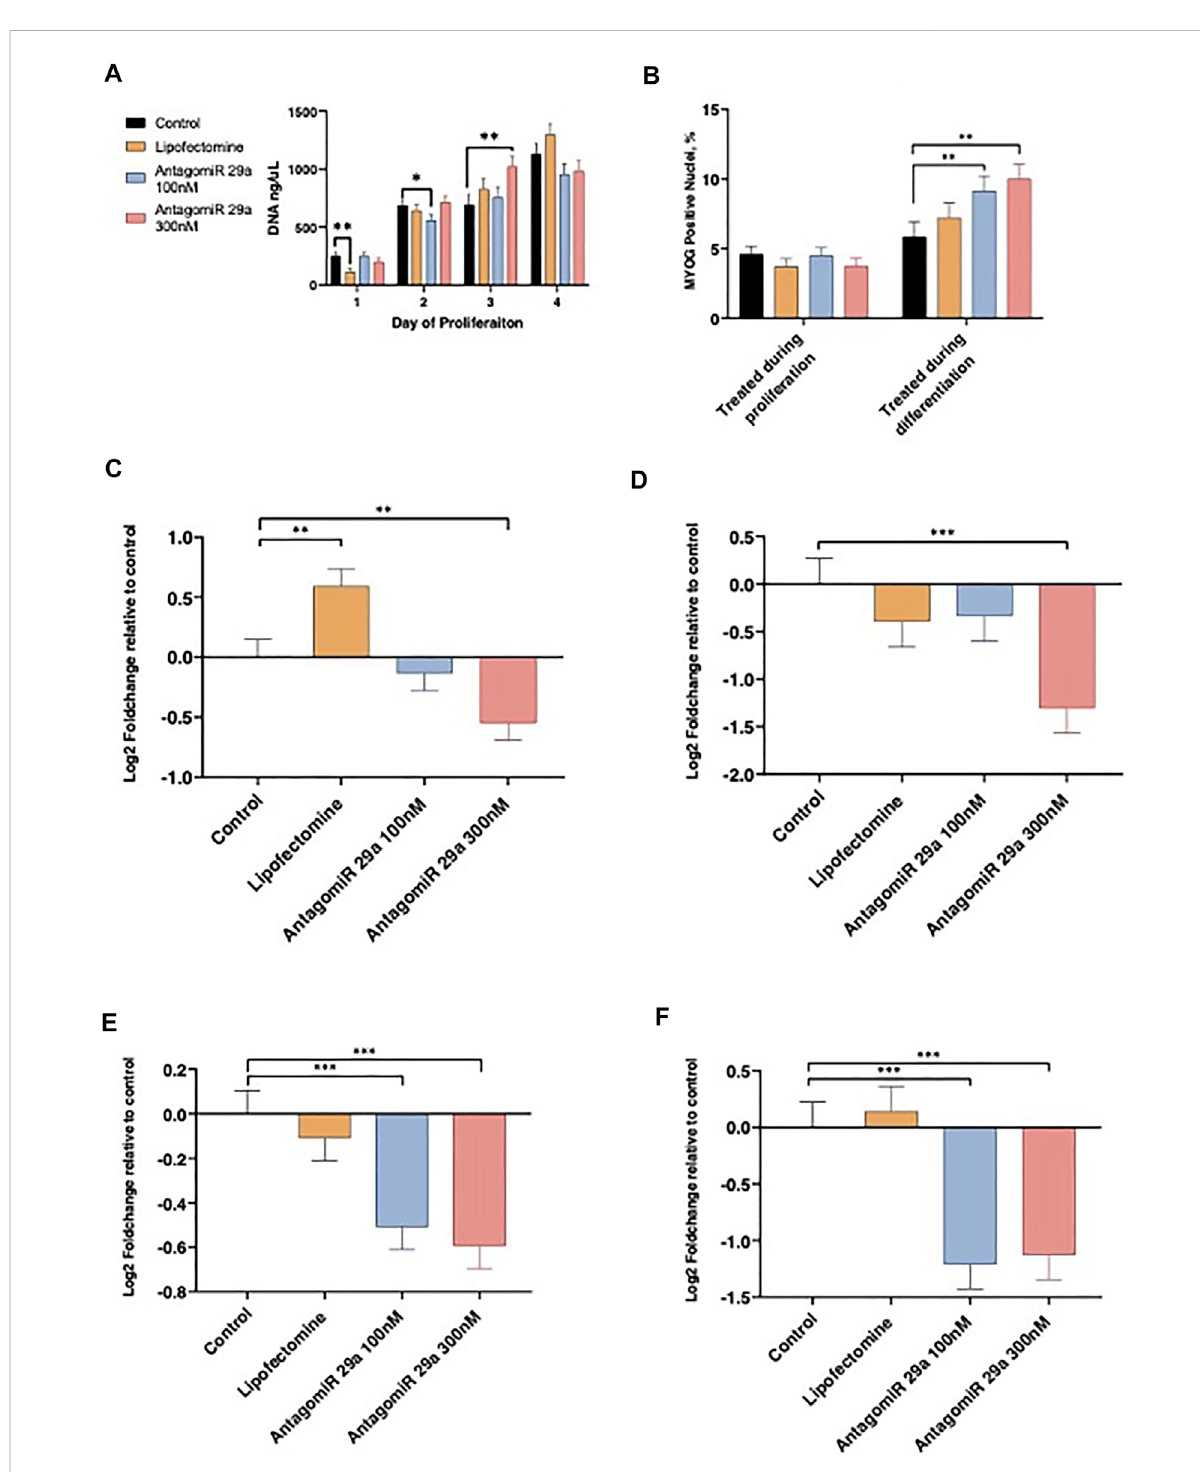
FIGURE 4 TheeffectsofmiR-29ainhibitiononsatellitecellproliferation,differentiation,andmiRNAexpression.AlterationsfrommiR-29ainhibitiontocell culture DNA content by day of proliferation (A) . miR-29a inhibition during proliferation or differentiation on the percentage of the total nuclei expressingMYOG (B) .miR-29aexpressionond1ofproliferation (C) andd4ofproliferation (D) .miR-29aexpressionfromcellculturestreatedduring proliferation (E) or differentiation (F)